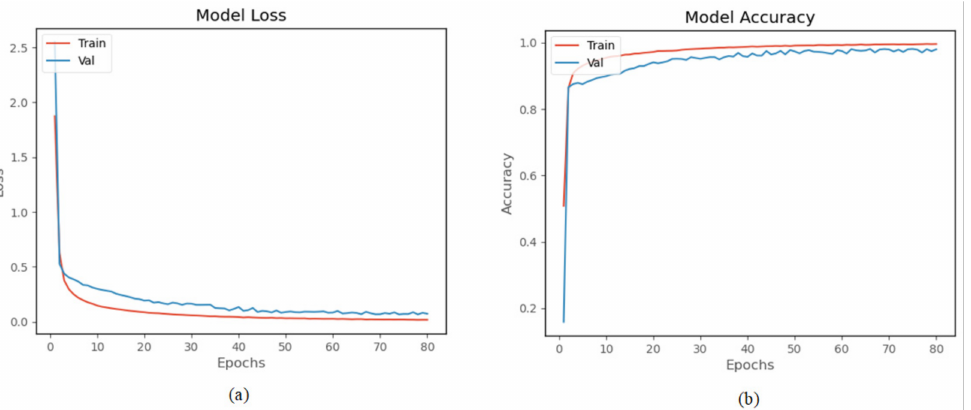
Figure 17. Results of the model on PAMAP2 dataset: ( a ) training loss and validation loss, and ( b ) training accuracy and validation